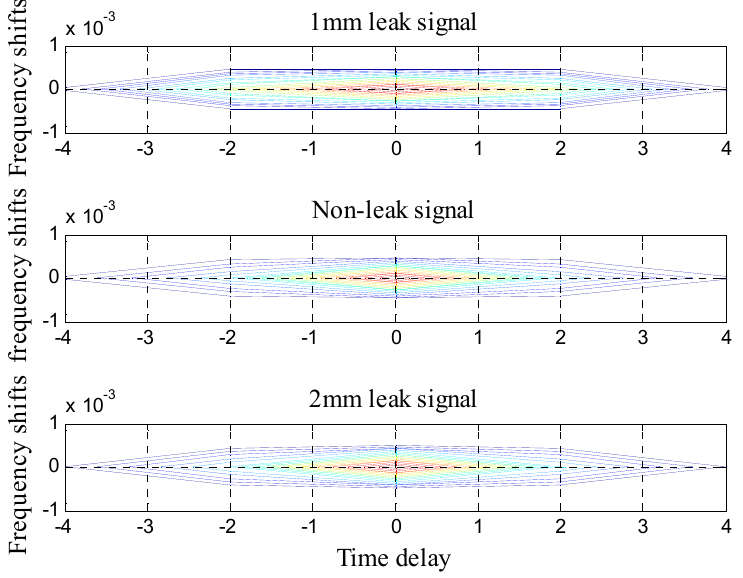
Figure 9. Ambiguity function images of de-noised signals.